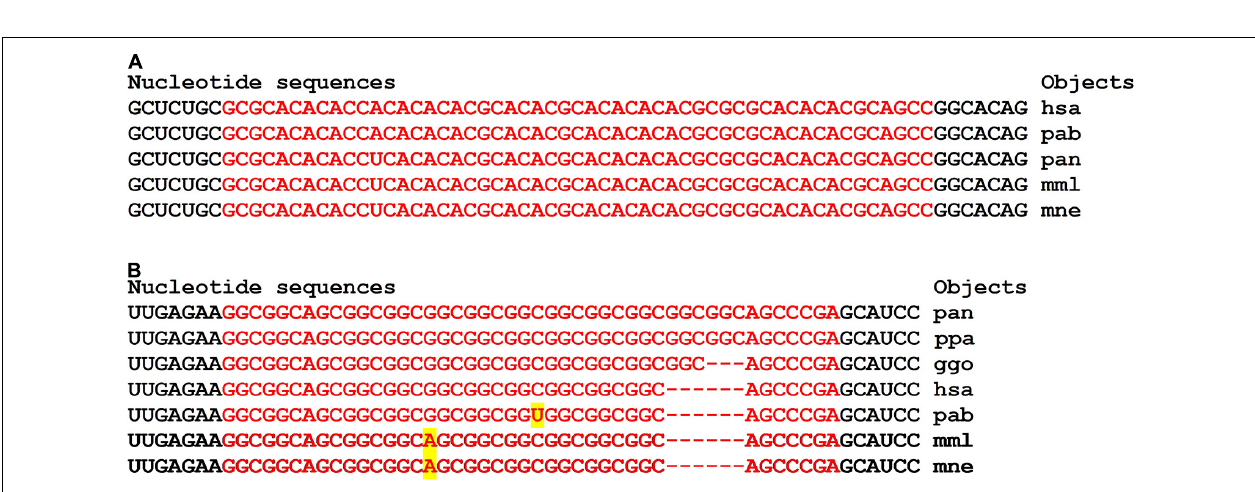
FIGURE 4 | Nucleotide sequences of 5 (cid:48) UTR regions of mRNAs of orthologous PPARGC1A genes containing the first cluster (A) and the second cluster (B) of miRNAs binding sites.